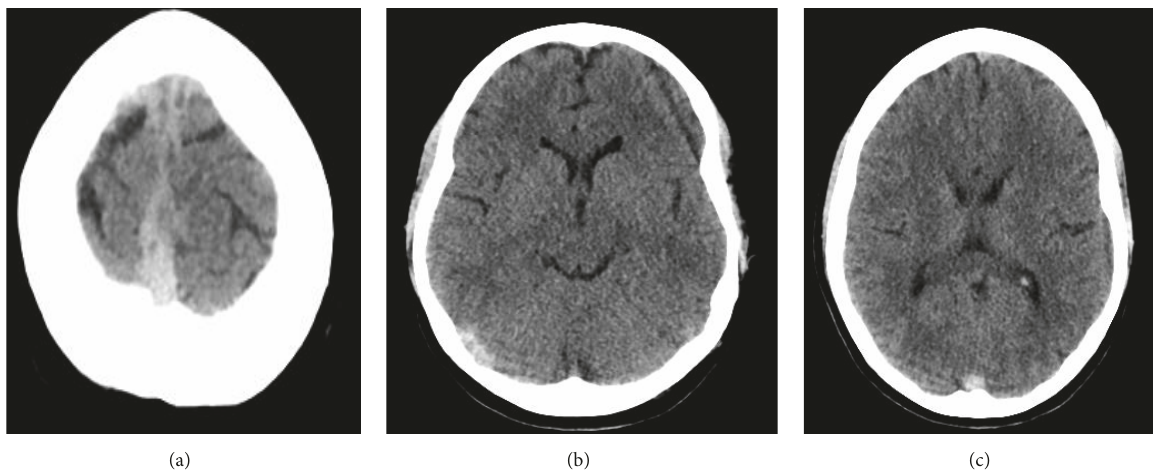
Figure 4: Initial head CT without contrast in our patient described above noted a falcine with bifrontal subdural hematoma at the vertex (a). Note the hyperdense right transverse sinus (b) and “filled delta sign” (c).